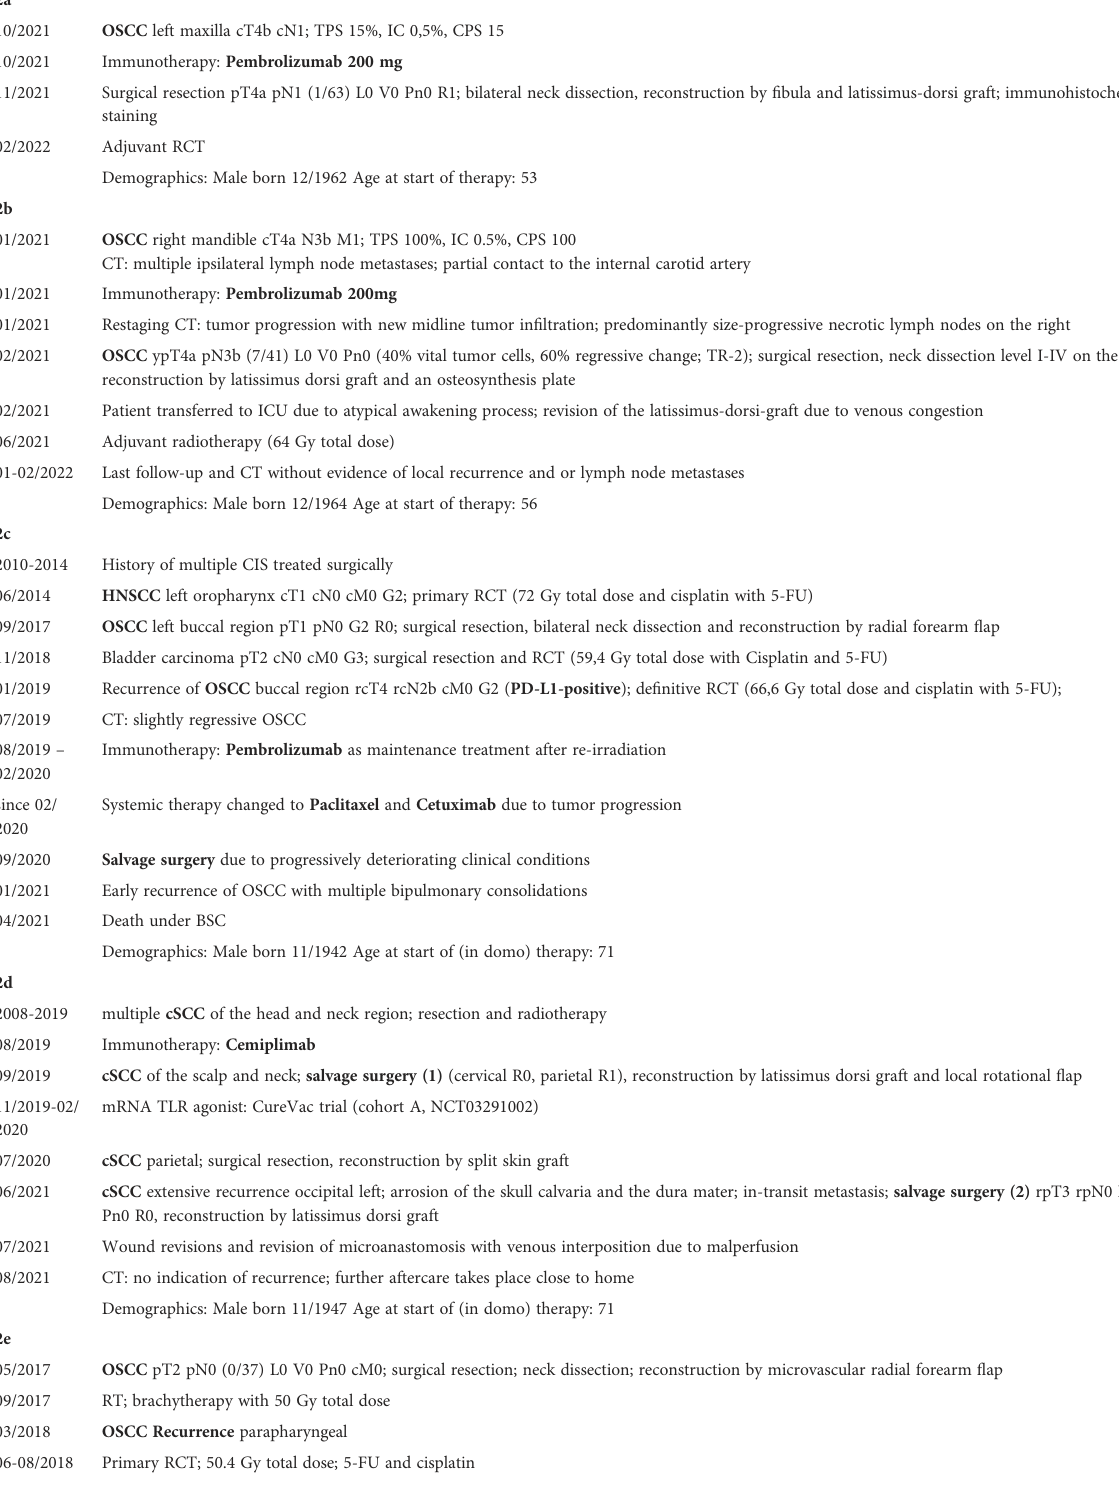
TABLE 2 Time history.